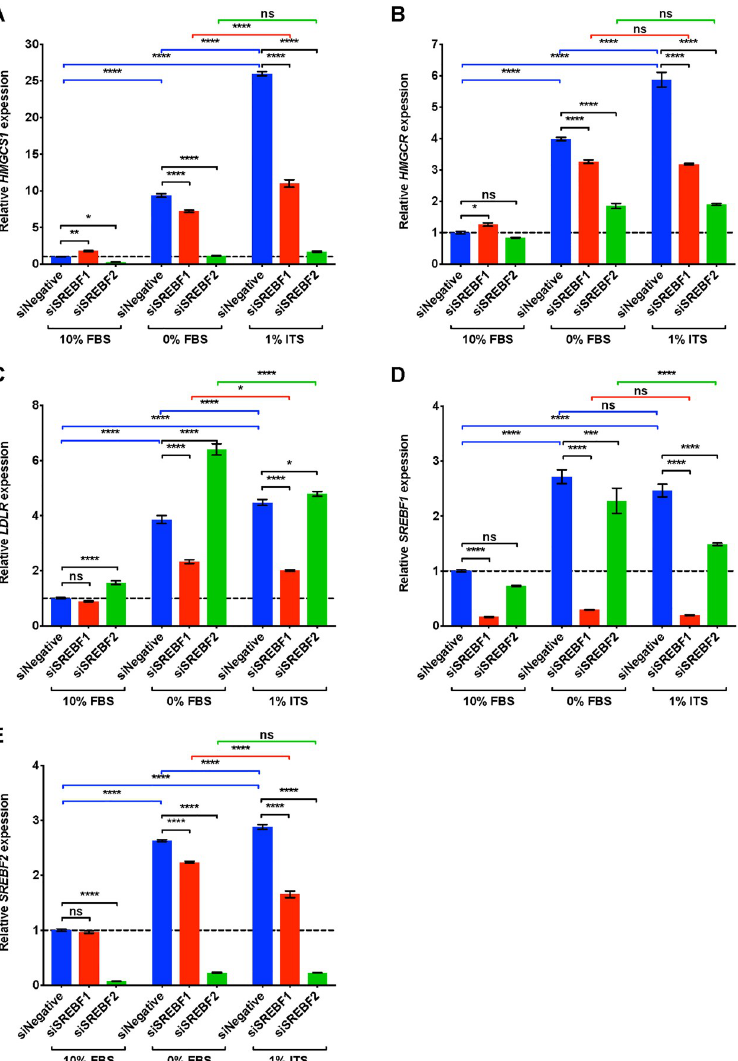
control, SREBF1 or SREBF2 . Transfected cells were cultured in 10%, 0% FBS or 1% ITS for two more days before RT- qPCR analyses. RT-qPCR results are presented as expression of genes relative to their expression under scramble siRNA treatment (siNegative) in 10% FBS medium (set as 1 and marked with a dashed line). When a significant interaction between siRNA treatment and medium condition was detected by two-way ANOVA, individual gene expression was compared within groups by post hoc Tukey’s multiple comparison tests. Each data point represents the mean ± SD of triplicate samples. � , P < 0.05; �� , P < 0.01; ��� , P < 0.001; ���� , P <